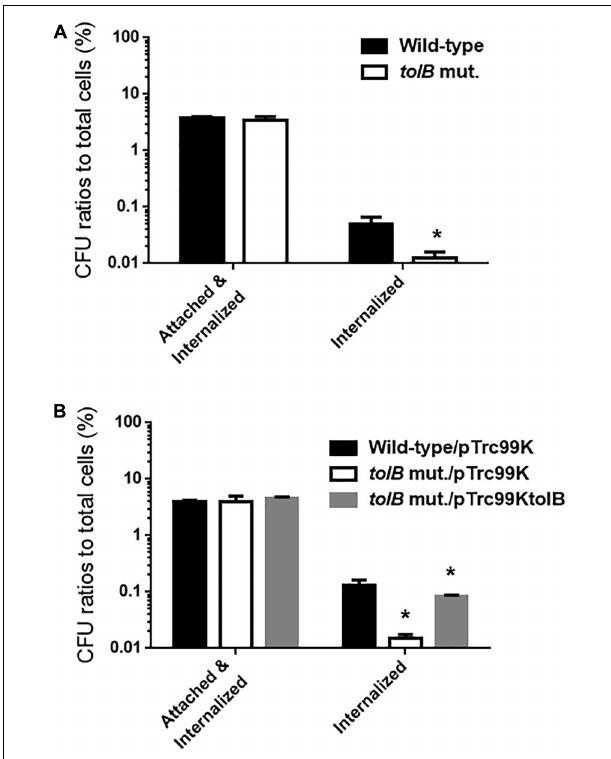
FIGURE 2 | Adhesion to and internalization of bladder epithelial cells (HTB-9) for the wild-type parent and the tolB mutant (A) or the wild-type parent and the tolB mutant carrying pTrc99K (empty vector) or pTrc99KtolB ( tolB expression plasmid) (B) . Y -axis on the graphs shows percent (%) of CFU (colony forming units) values of adhered and internalized bacteria relative to total bacterial cell numbers. Data plotted are the means from three independent experiments; error bars indicate the standard deviations, ∗ P < 0.01. Asterisks denote significance for values relative to the wild-type control.